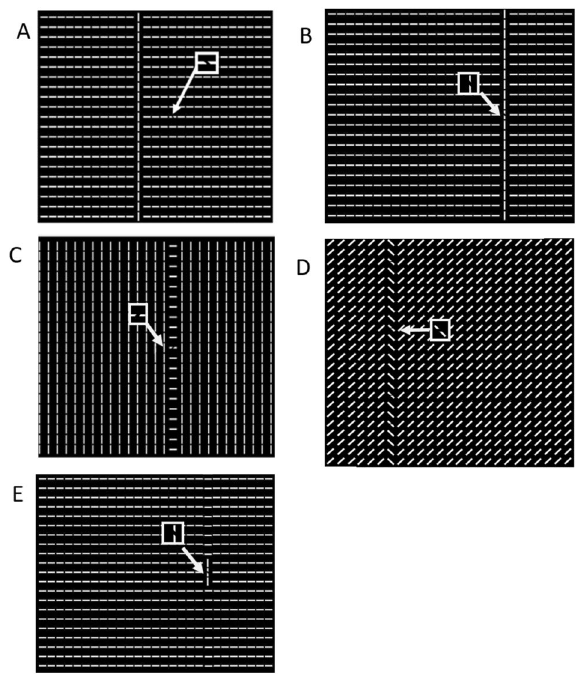
Figure 1. Visual search displays with ( A ) a non-overlapping target and ( B – E ) an overlapping target on a ( B ) full-length collinear structure, ( C ) ladder-like/non-collinear structure, ( D ) slant structure, and ( E ) short collinear